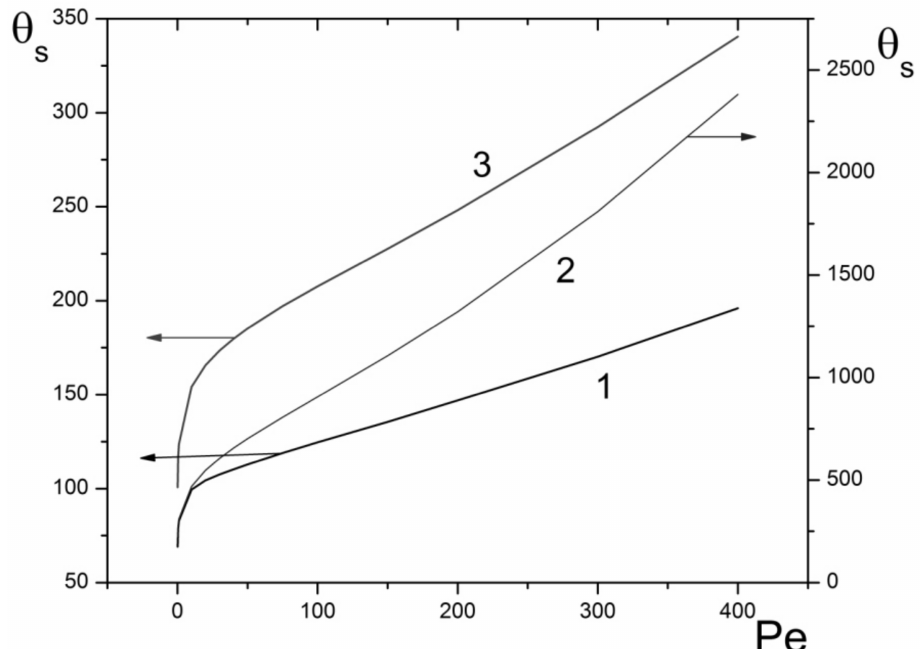
Figure 5. Monotonic critical curves. Approximate model (29). Ar = 0.02; h s = 7.14 × 10 2 ; µ = 75.0; 1—A = 2.75 × 10 − 13 ; g = 1.22 × 10 − 15 ; 2—A = 2.75 × 10 − 15 ; g = 1.22 × 10 − 17 ; 3—A = 2.75 × 10 − 18 ; g = 1.22 × 10 − 20 .